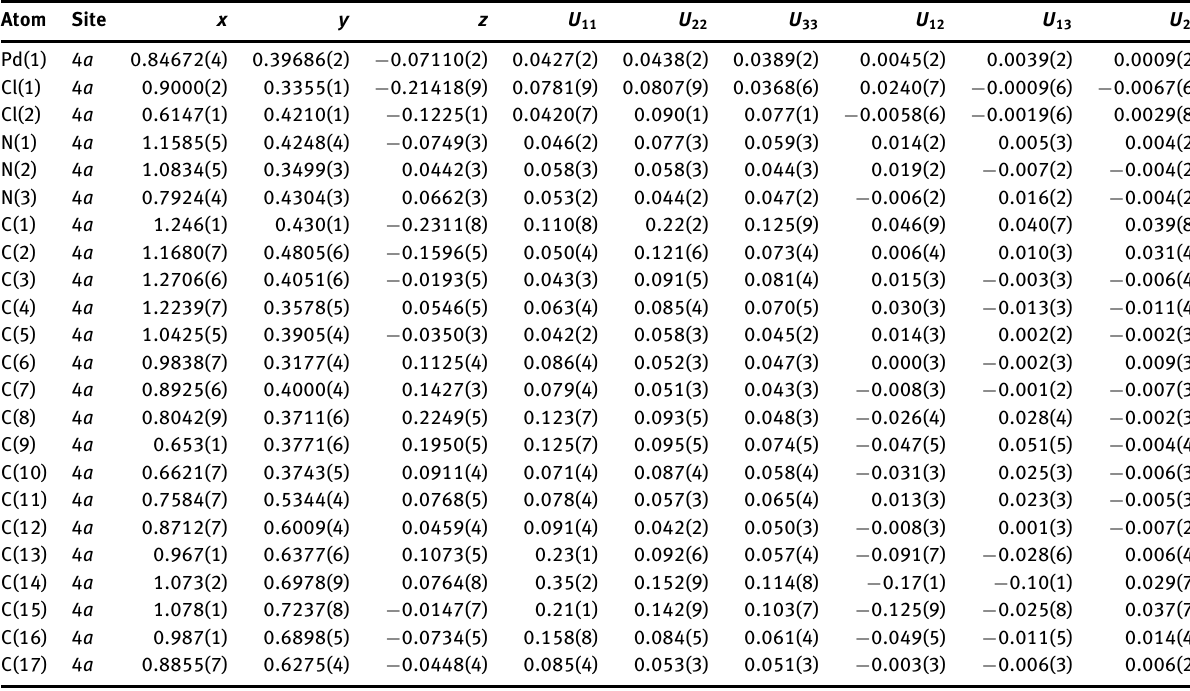
Table 3: Fractional coordinates and atomic displacement parameters (Å 2